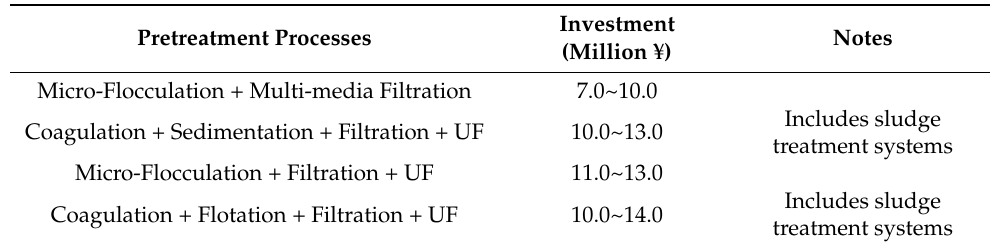
Table 4. The investment estimates of common combined pretreatment processes. Information is from Wu et al.